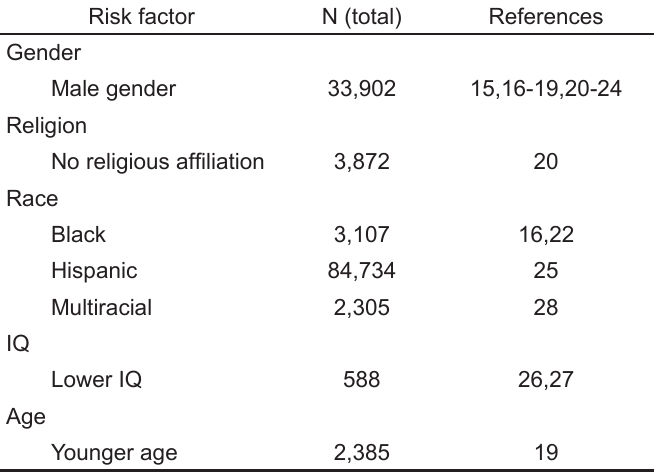
Table 1. Personal risk factors found to be correlates for violence in adolescents.